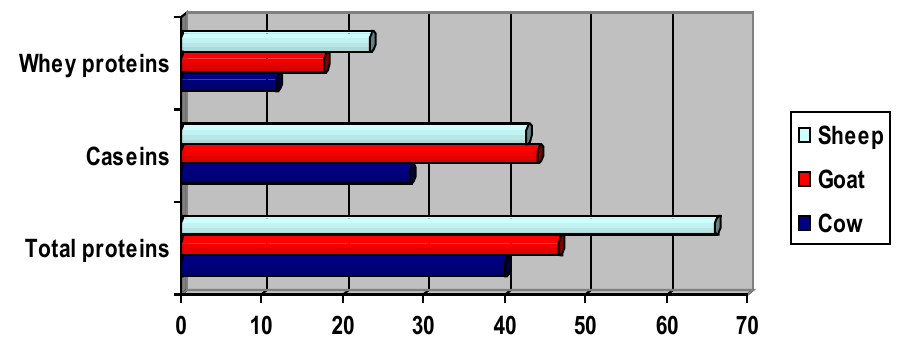
Fig. 2 The profile of proteins in cow, goat and sheep